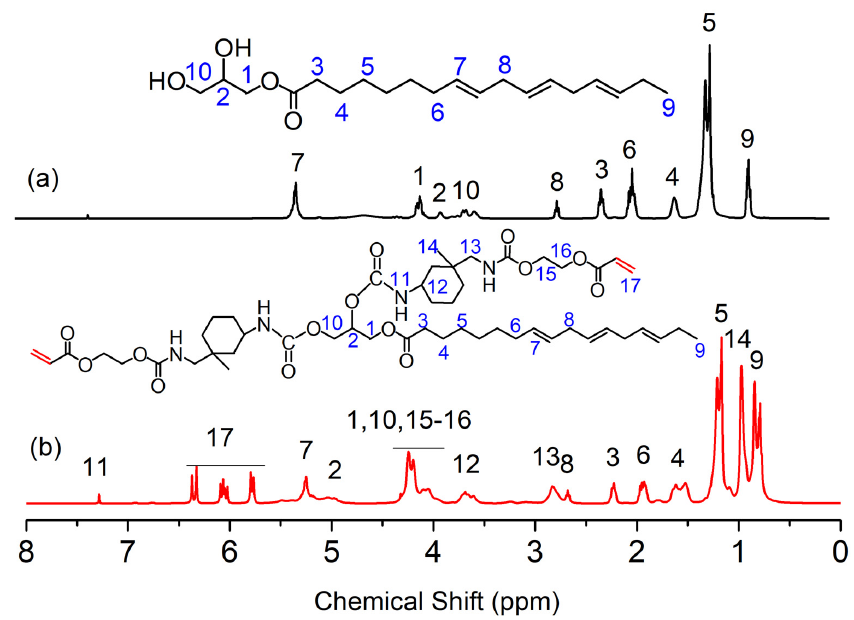
Figure 2. 1 H NMR spectra of ( a ) HRSO and ( b )